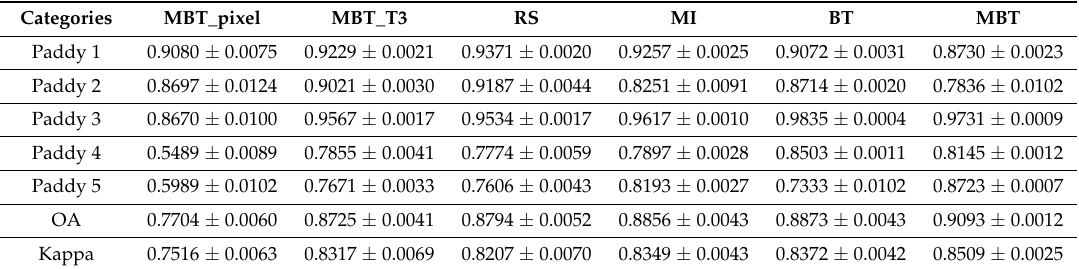
Table 4. Classification results for the UAVSAR imagery with different strategies.